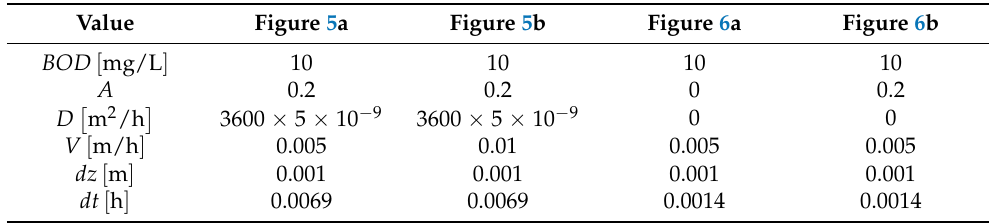
Table 2. Values used in